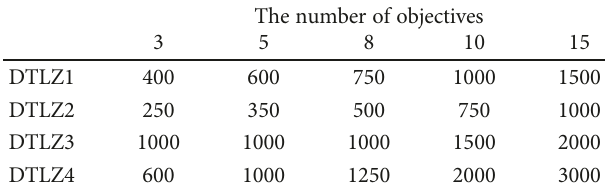
Table 6: Maximum iteration for each test problem.